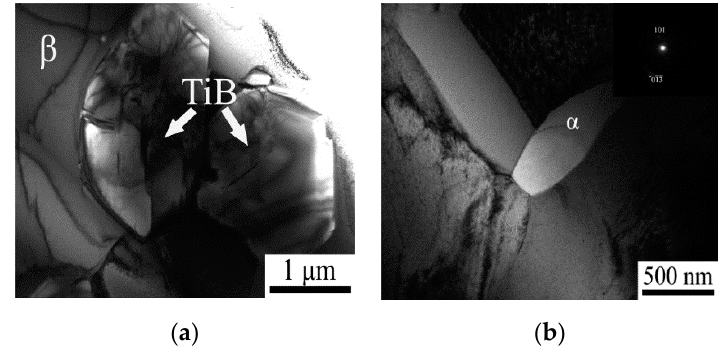
Figure 6. TEM images of Ti-15Mo/TiB composite microstructure after hot rolling.